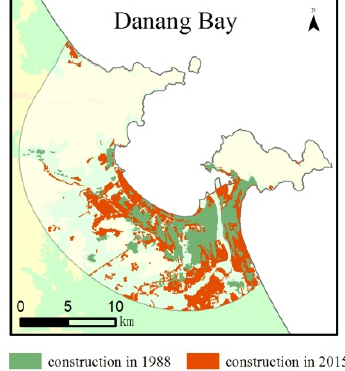
Figure 14. Spatial distribution of construction land in Danang Bay.